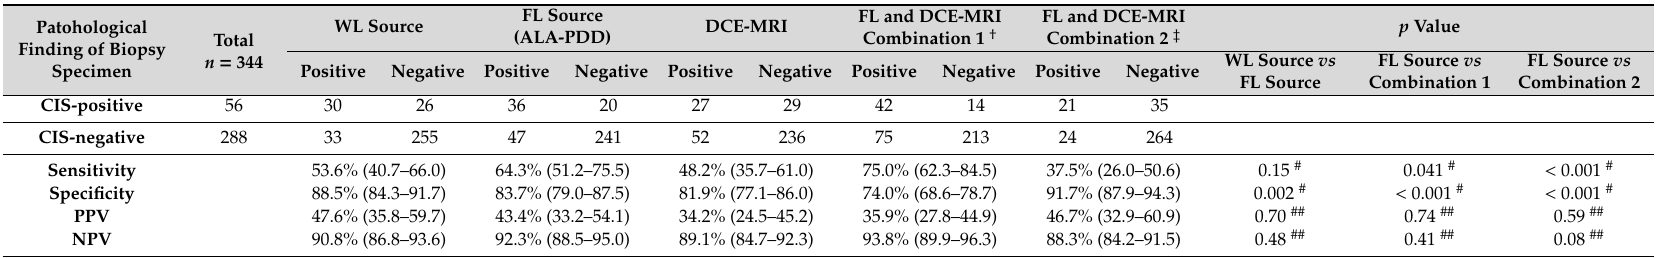
Table 3. The overall detection accuracy for bladder CIS in 45 patients undergoing PDD-TURBT for suspected